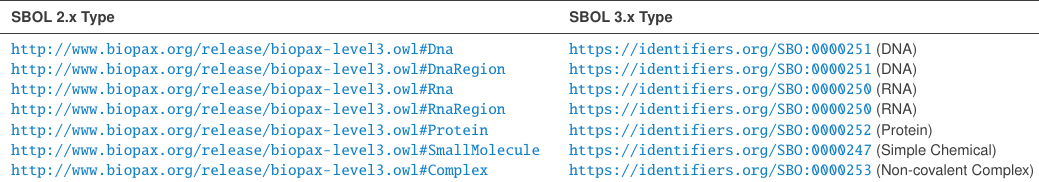
Table 18: Mapping of SBOL2 ComponentDefinition types to SBOL3 Component